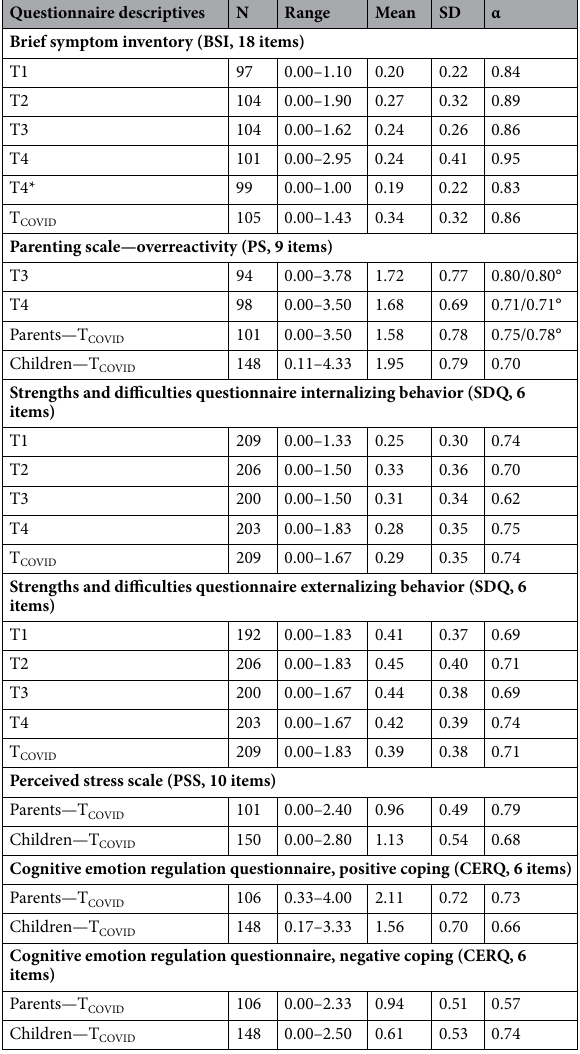
Factors influencing perceived stress during COVID‑19 lockdown. Coping strategies. Positive and negative coping strategies were significantly positively associated in both parents ( r = .22, p = .024) and children ( r = .23, p = .006). Parent–child correlations showed a significant association between the child’s and the parent’s negative coping ( r = .18, p = .028), which was not significant for positive coping strategies ( r = 06, p = .503). For both parents and children, we examined whether positive and negative coping strategies influenced perceived stress, while controlling for confounding variables (age, education level primary parent and number of people in the household during lockdown). We first performed a multiple regression analyses with parental perceived stress as the dependent variable, parental negative and positive coping strategies as independent vari- ables and parental age, parental education level and the number of people in the household during lockdown as confounds. A significant regression was found: F (5, 100) = 3.96, p = .003, r 2 = .17. The individual predictors indi- cated that parental education ( B = − .12, p = .033); number of people in the household ( B = .12, p = .009); and nega- tive coping strategies ( B = .24, p = .011) were significant predictors of parental perceived stress during lockdown. Secondly, we performed a multiple regression analyses with children’s perceived stress as the dependent vari- able, children’s negative and positive coping strategies as independent variables and children’s age, parental edu- cation level and the number of people in the household during lockdown as confounds. A significant regression was found ( F (5, 142) = 11.19, p < .001, r 2 = .28. The individual predictors indicated that negative coping strategies ( B = .57, p < .001) were a significant predictor of children’s perceived stress during lockdown.